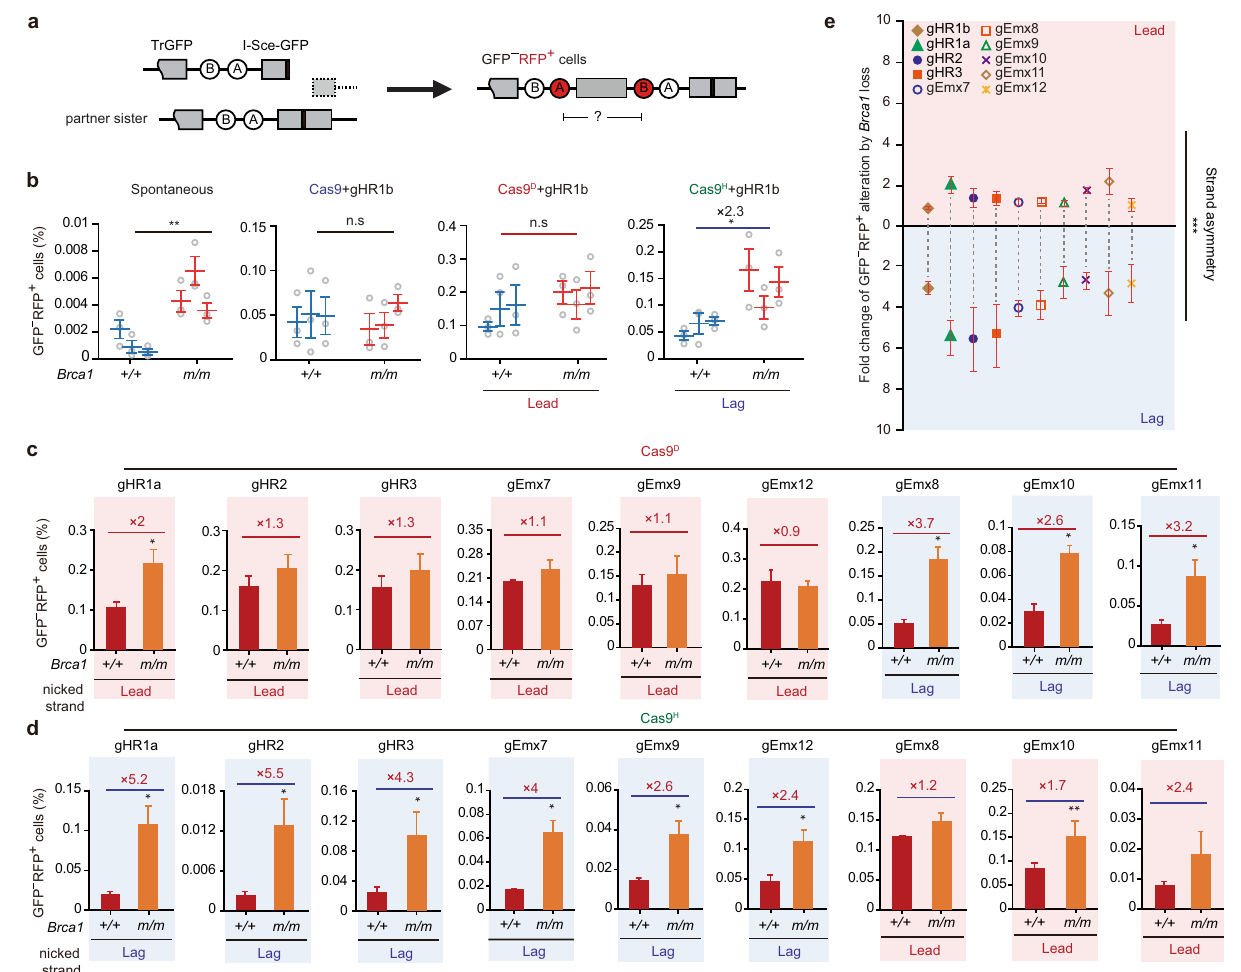
Fig. 5 | BRCA1 suppresses nick-induced TDs in a strand-biased manner. a Schematic of GFP − RFP + products generated from the SCR-RFP reporter. b Spontaneous,Cas9-gHR1b-andnCas9-gHR1b-inducedGFP − RFP + productsinthree of Brca1 +/+ and Brca1 m/m clones containing the SCR-RFP reporter. c , d Frequency of GFP − RFP + cells induced by Cas9 D ( c ) or Cas9 H ( d ) together with one of 9 sgRNAs in Brca1 +/+ and Brca1 m/m cells. The replication strand that encounters nCas9-induced nicks is indicated. The fold of increase between Brca1 +/+ and Brca1 m/m cells is stated above each pair of columns for indicated nCas9-sgRNA. e Combined analysis of